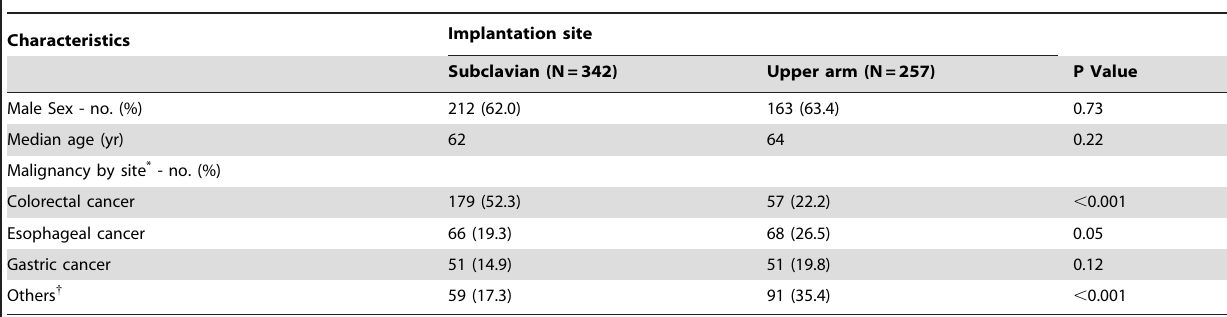
Table 1. Characteristics of the Patients.